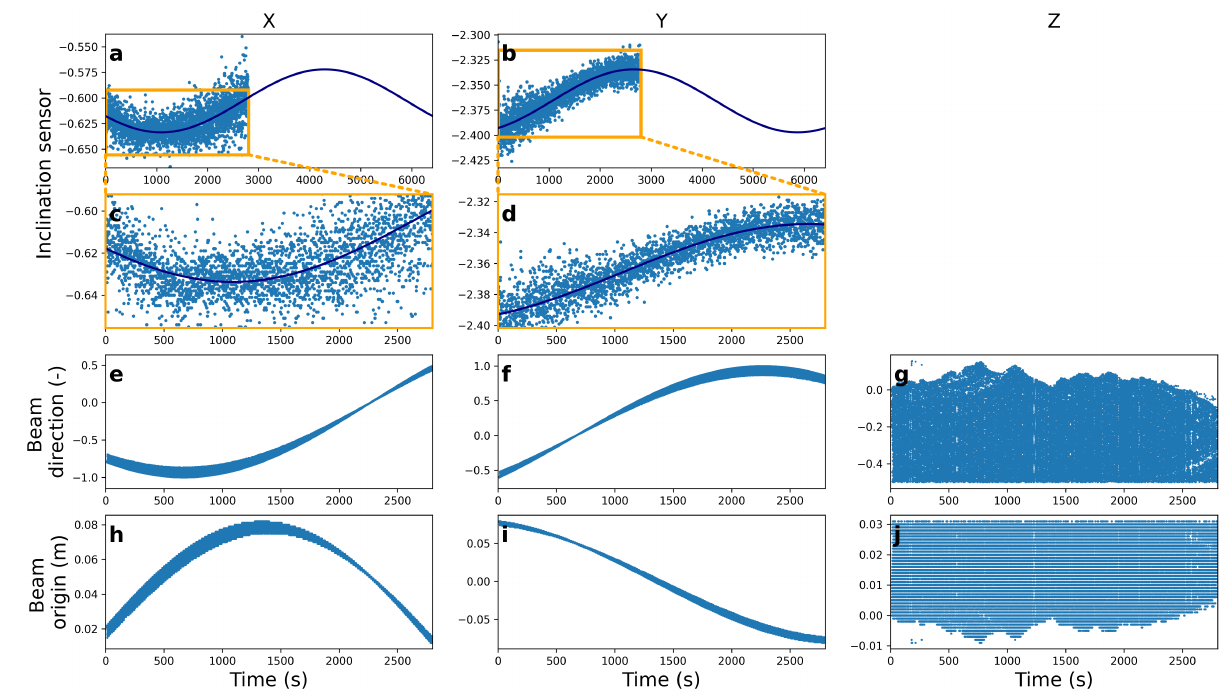
Figure 4. The observed roll and pitch data compared with the beam direction and origin of individual laser pulses. a) Roll data (dots) and its trend over time (dark blue line), b) pitch data (dots) and its trend over time (dark blue line), c)+d) zoomed area of the orange boxes in a) and b) respectively; e)-g) beam direction and h)-j) beam origin as read from the raw data sampled at every 1000th point for the reference scan of 5 November 10:55